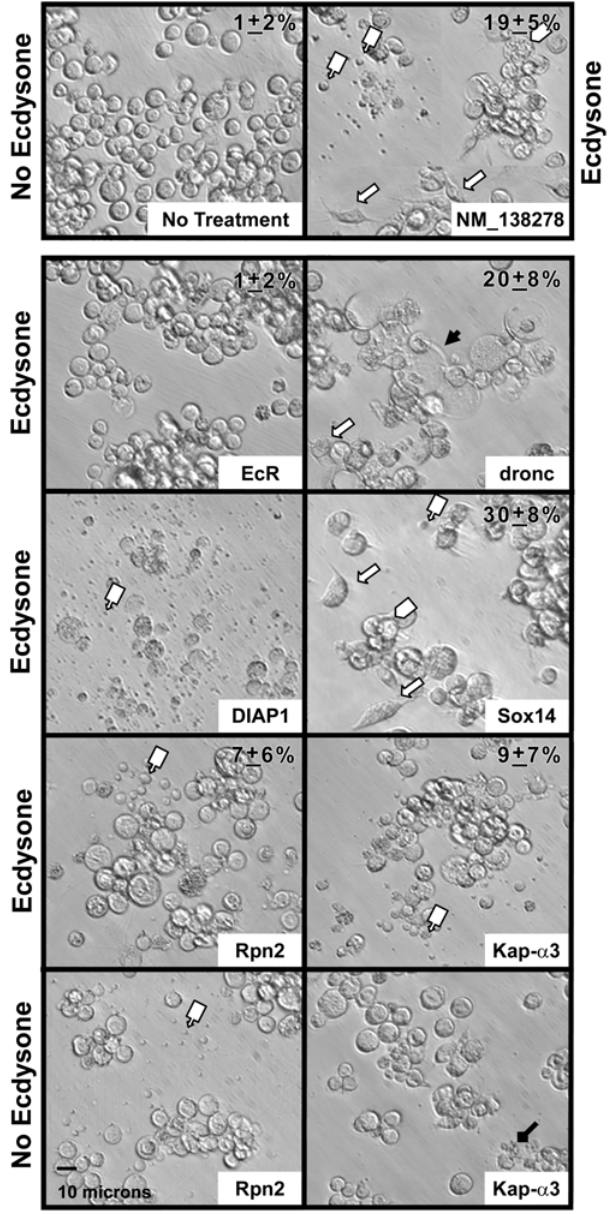
Figure 3. Cellular morphology of l(2)mbn cells after dsRNA treatment. Cellular phenotypes were visualized 3 days after dsRNA treatment in the presence or absence of ecdysone. The l(2)mbn cells with no ecydsone and no dsRNA (No treatment) were round and uniform in size and shape. l(2)mbn cells treated with ecdysone (not shown) or ecdysone + human dsRNA NM_138278-negative control changed in shape, from round to spindle forms with extensions ( ) (19 + / 2 5%). Large cells with phagocytosed material ( morphologies were distinct. The % of observed spindle shaped cells (top right corner) was quantitated for dsRNAs corresponding to the genes indicated. RNAi of EcR inhibited spindle shape formation (1 + / 2 2% of the cells were spindle shaped), cells remained rounded, and no apoptotic bodies were found. RNAi of dronc inhibited apoptotic body formation, but cells became spindle shaped (20 + / 2 8%). Also, signs of necrosis such as inflated and seemingly empty cells and cell fragments were observed ( ). RNAi of Sox14 showed few apoptotic bodies and 30 + / 2 8% of the cells were spindle-shaped. RNAi of diap1 resulted